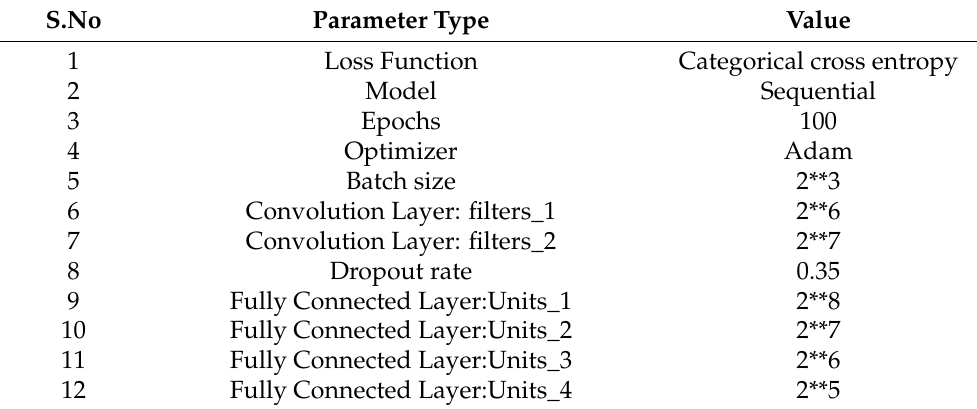
Table 3. Selected Parameters for CNN Model for two data sets.